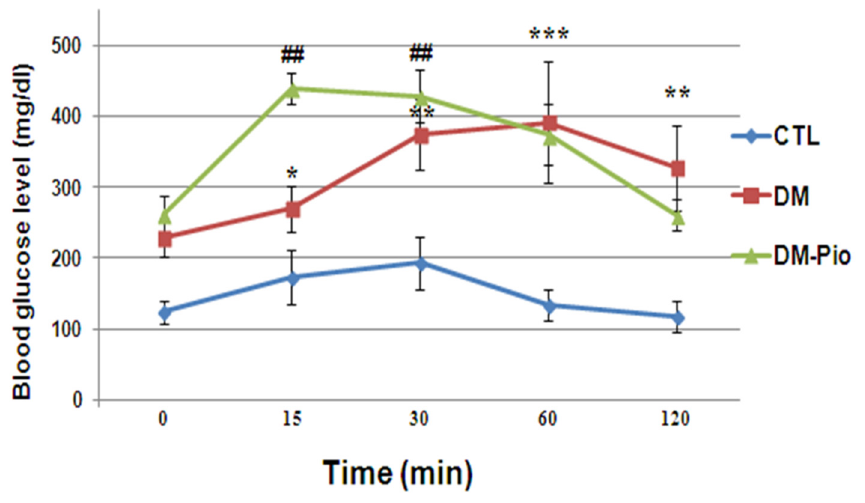
Figure 6. Changes in blood glucose level in oral glucose tolerance test (OGTT) performed in diabetes mice after 2-week treatment with pioglitazone. The blood glucose levels (mg/dl) were measured at different time points using hand-held glucometer. Fasting blood glucose concentration was used as a reference for OGTT. Data were expressed as mean ± SD. Blue line (CTL): non-diabetic mice; red line (DM): diabetic mice; green line (DM-Pio): pioglitazone-treated mice [30 mg/kg, po ]. One-way ANOVA, followed by Tukey’s post hoc test was used. * p < 0.05; ** ## p < 0.01; *** p < 0.001 compared with baseline level of glucose (before the glucose load).